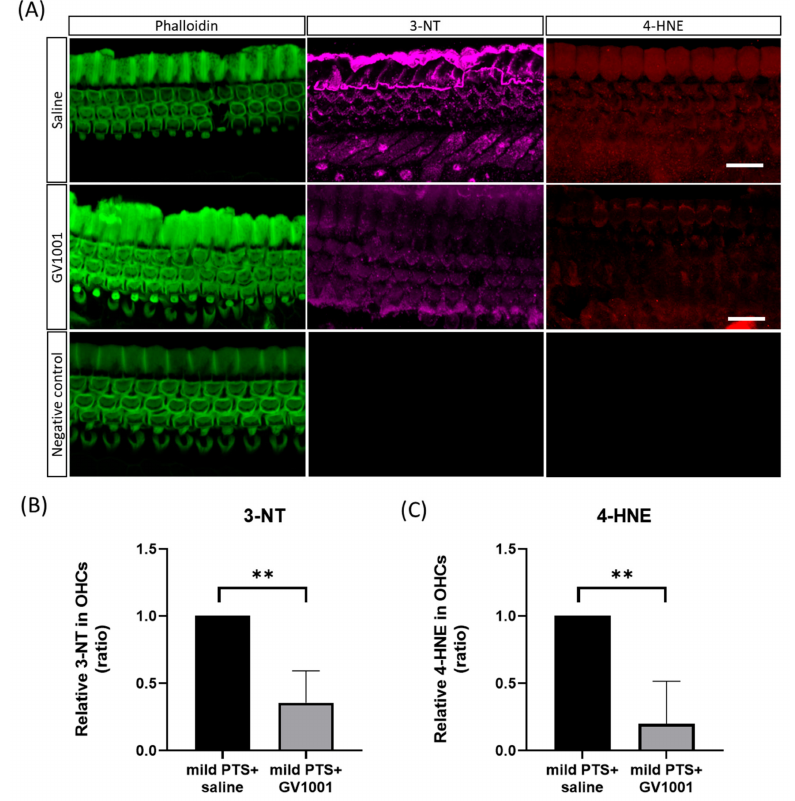
Figure 5. E ff ect of GV1001 on oxidative stress marker levels. ( A ) Immunolabeled 3-NT (purple) and 4-HNE (red) OHCs stained green with phalloidin 1 h after moderate PTS-noise exposure. The staining intensity of the GV1001 group is markedly weaker than that of the control group. As for negative control, no immunoreactivity was observed in the state of attaching only secondary antibody to verify whether the expression of 3-NT and HNE is reactive by oxidative stress. ( B , C ) GV1001 pretreatment significantly attenuated the immunoreactivities of 4-HNE and 3-NT ( n = 5, 10 ears). All groups contained 5 mice. ** p < 0.005 (Mann–Whitney U-test). Scale bar: 10 µ